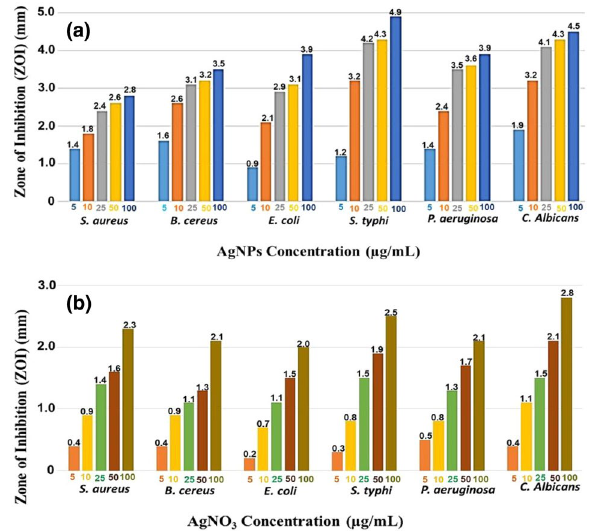
Figure 6. Antimicrobial activity of different concentrations of Ag@Ag 2 O NCs ( a ) and AgNO 3 ( b ) against some prokaryotic and eukaryotic pathogens.